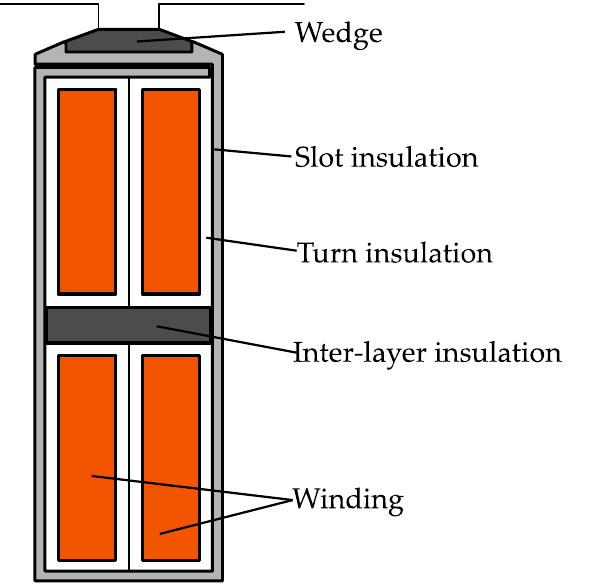
Figure 2. Cross-section of a slot of an electric motor with a double-layer winding.